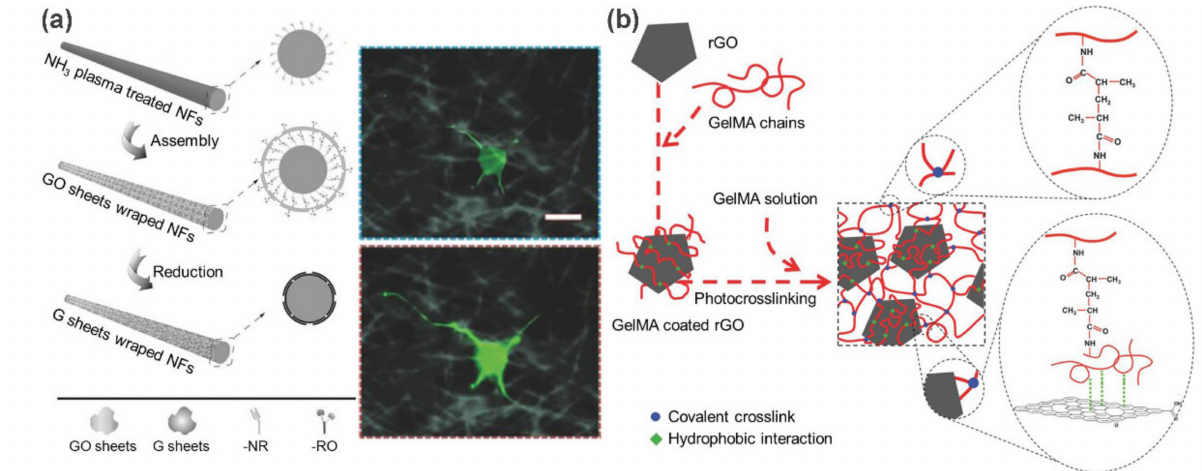
Figure 9. Preparation of electroactive bioscaffolds for soft tissue engineering applications. ( a ) Schematic illustration of the fabrication process of GO reinforced composite nanofibers G-NFs. Fluorescence images of the cells on G-NFs before and after pulse. ( b ) Preparation procedure of rGO-GelMA hybrid hydrogels. Adapted with permission from Refs. [63,64].